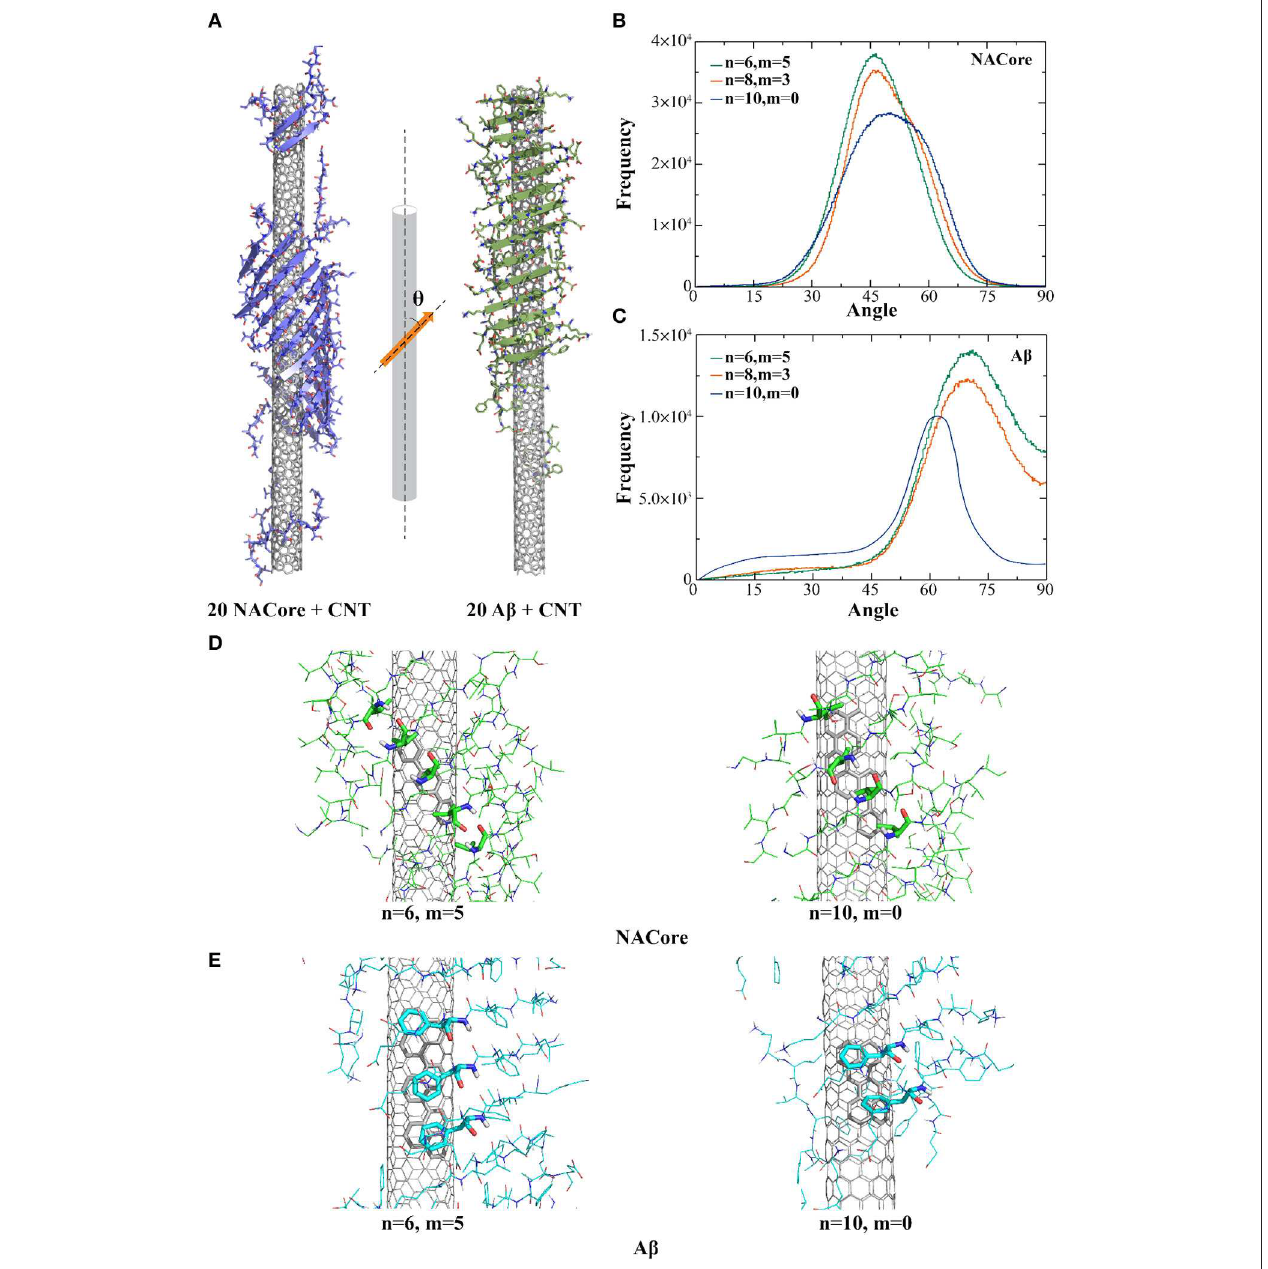
FIGURE 1 | Self-assembly of amyloid peptides in the presence of different chiral CNTs. (A) Typical snapshot structures of peptides forming β -sheet supercoils on the surface of CNTs, where NACore (purple) and A β (green) were shown in cartoon representation. The distribution of angles between β -strands and CNT axis were computed for the self-assemblies of NACore (B) or A β (C) in DMD simulations. Representative binding configurations of NACore (D) and A β (E) with armchair-like ( n = 6, m = 5) and chiral ( n = 10, m = 0) CNTs, where hydrophobic (Valine residues in NACore) or aromatic (Phenylalanine residues in A β ) interactions with CNTs were highlighted as